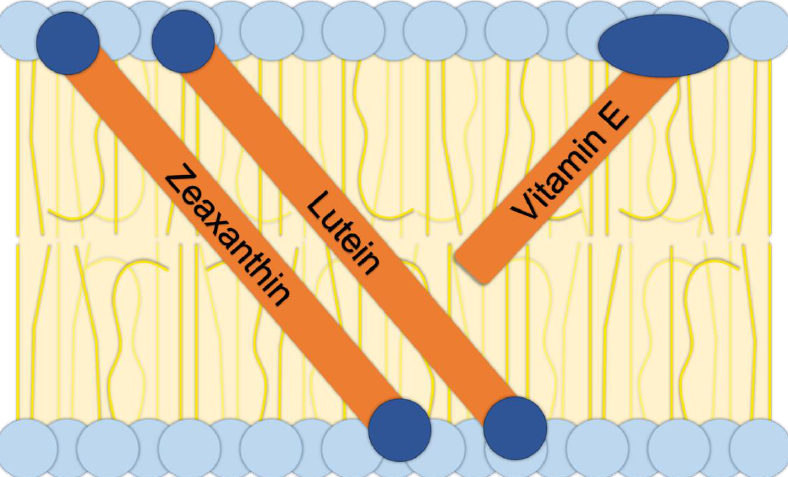
Figure 1. Schematic diagram depicting a biological membrane consisting of a phospholipid bilayer with embedded dietary micronutrients. The xanthophylls zeaxanthin and lutein span the entire width of the membrane, while vitamin E does not span the entire width. Hydrophobic portions of membrane phospholipids and of the embedded molecules are shown in yellow and orange, respectively. Hydrophilic membrane and micronutrient portions are shown in light blue and dark blue, respectively.